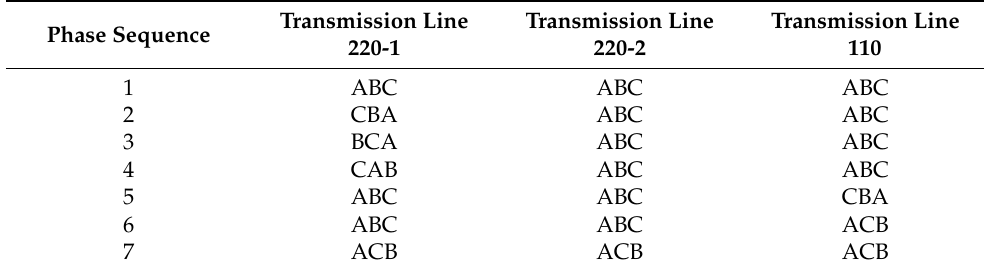
Table 5. Phase sequence options for the conductors of the first section of a three-circuit line. Transmission Line Transmission Line Transmission Line Phase Sequence 220-1 220-2 110 1 ABC ABC ABC